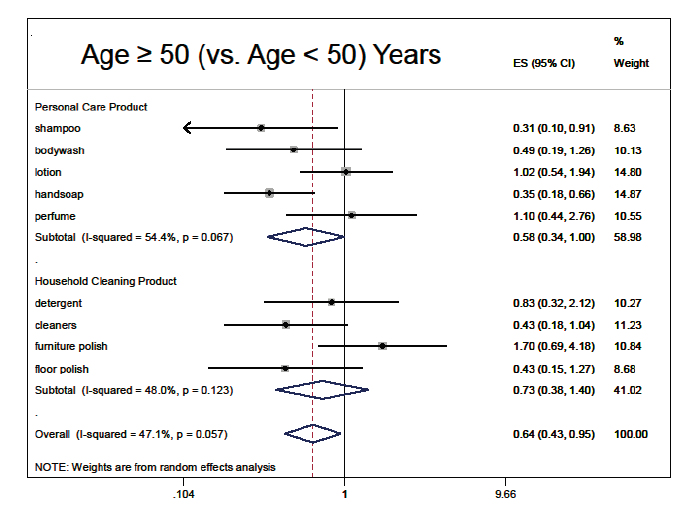
Figure 3. Demographic predictors of fragranced product use (meta-analysis of multivariable model results): age ≥ 50 ( vs. younger). Models are ordered logistic regressions with random intercepts for twin pair and address, with fixed effects for age, sex, education, ever being bothered by fragrance and race, restricted to white participants only ( N = 280). Missing data were imputed by multiple imputation with chained equations. Model estimates are combined by random-effects meta-analysis by product type.